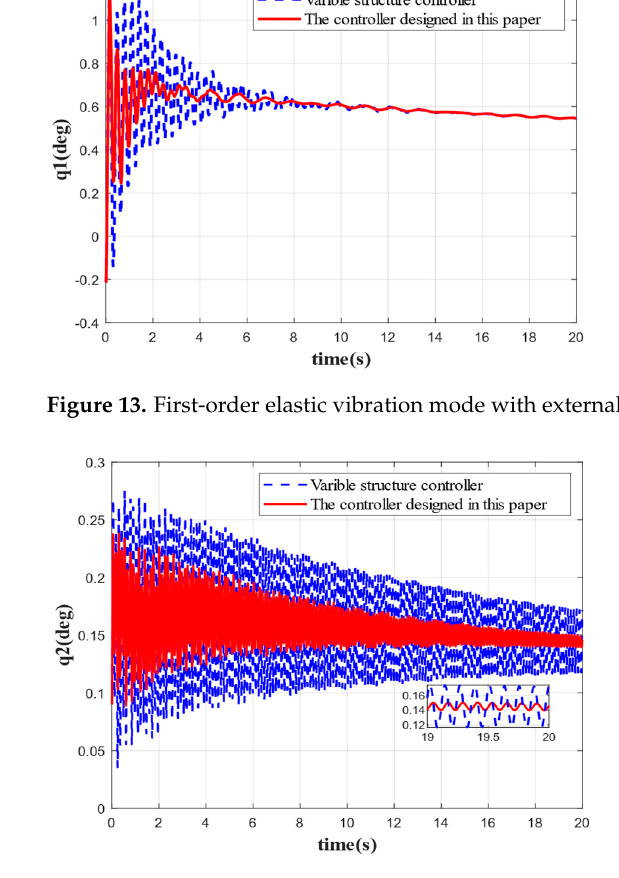
Figure 15. Third ‐ order elastic vibration mode with external interference.